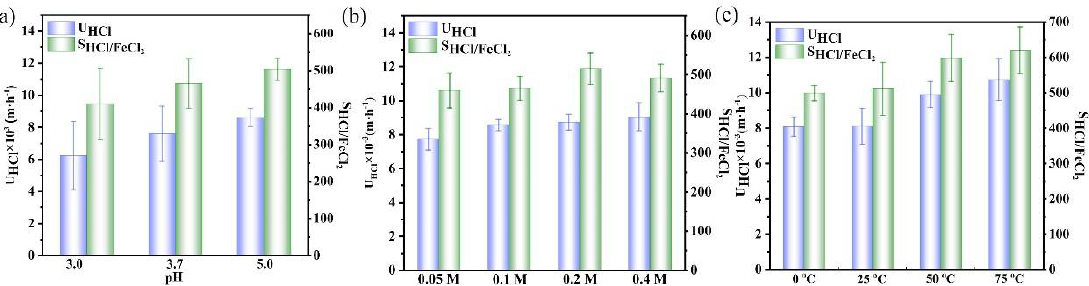
Figure 7. ( a ) H + dialysis coefficient (U HCl ) and H + /Fe 2+ separation factor (S HCl/FeCl2 ) of U-C(60)/QPPO membranes with different pH values. ( b ) H + dialysis coefficient (U HCl ) and H + /Fe 2+ separation factor (S HCl/FeCl2 ) of U-C(60)/QPPO membranes with different ionic strengths. ( c ) H + dialysis coefficient (U HCl ) and H + /Fe 2+ separation factor (S HCl/FeCl2 ) of U-C(60)/QPPO membranes with different temperatures.